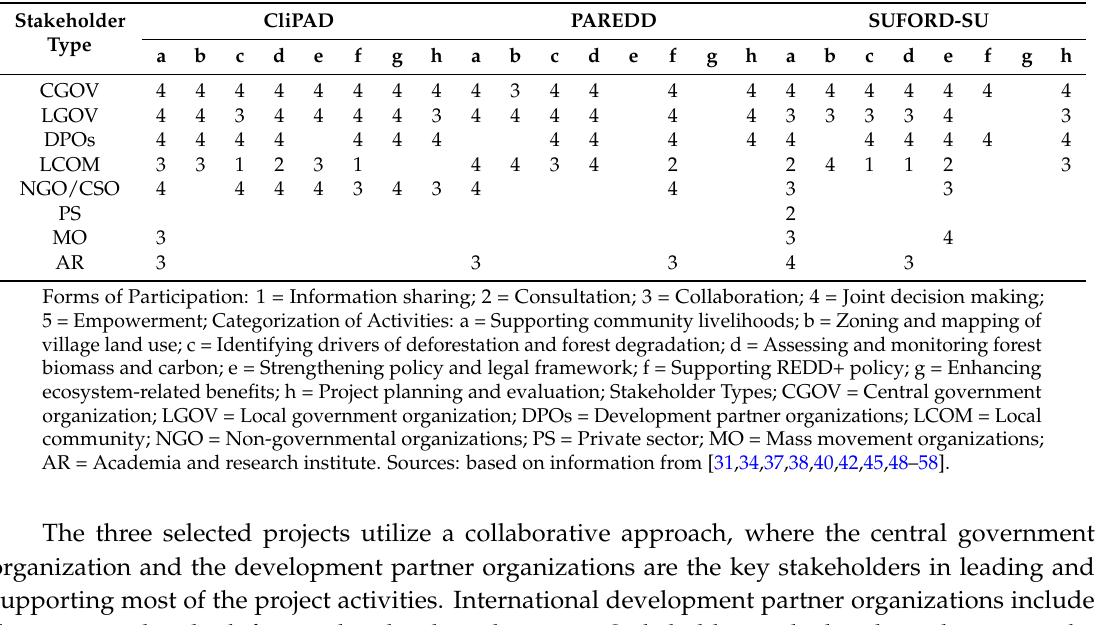
Table 5. Forms of stakeholder participation in three selected